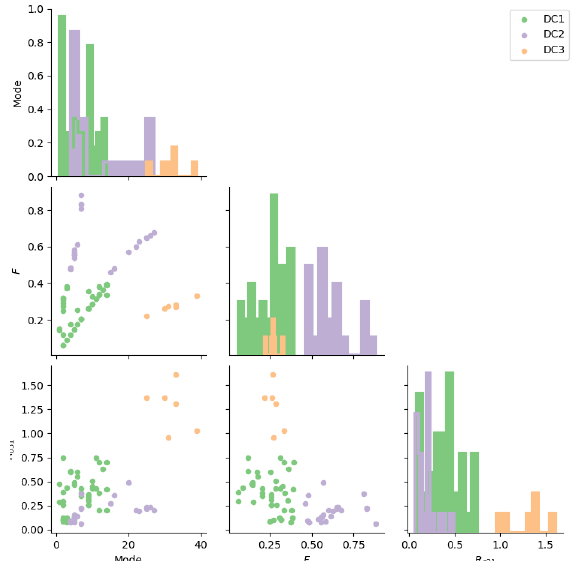
Figure 6. Scatter plots for the resulting three clusters obtained for the K-means algorithm in the parameter space defined by the oscillation mode, stress ratio ( R σ 31 = max ( std ( σ 3 )) / max ( std ( σ 1 )) ), and relative bending stiffness ratio ( F = f n , b / f n , tot ). The method assumes the clusters to be spherical in parameter space. Gaussian Mixture [33–35] is a probabilistic model that assumes that all data points originate from a predetermined number of overlapping Gaussian distributions with unknown parameters. The results of Gaussian mixture clustering are shown in Figure 7.